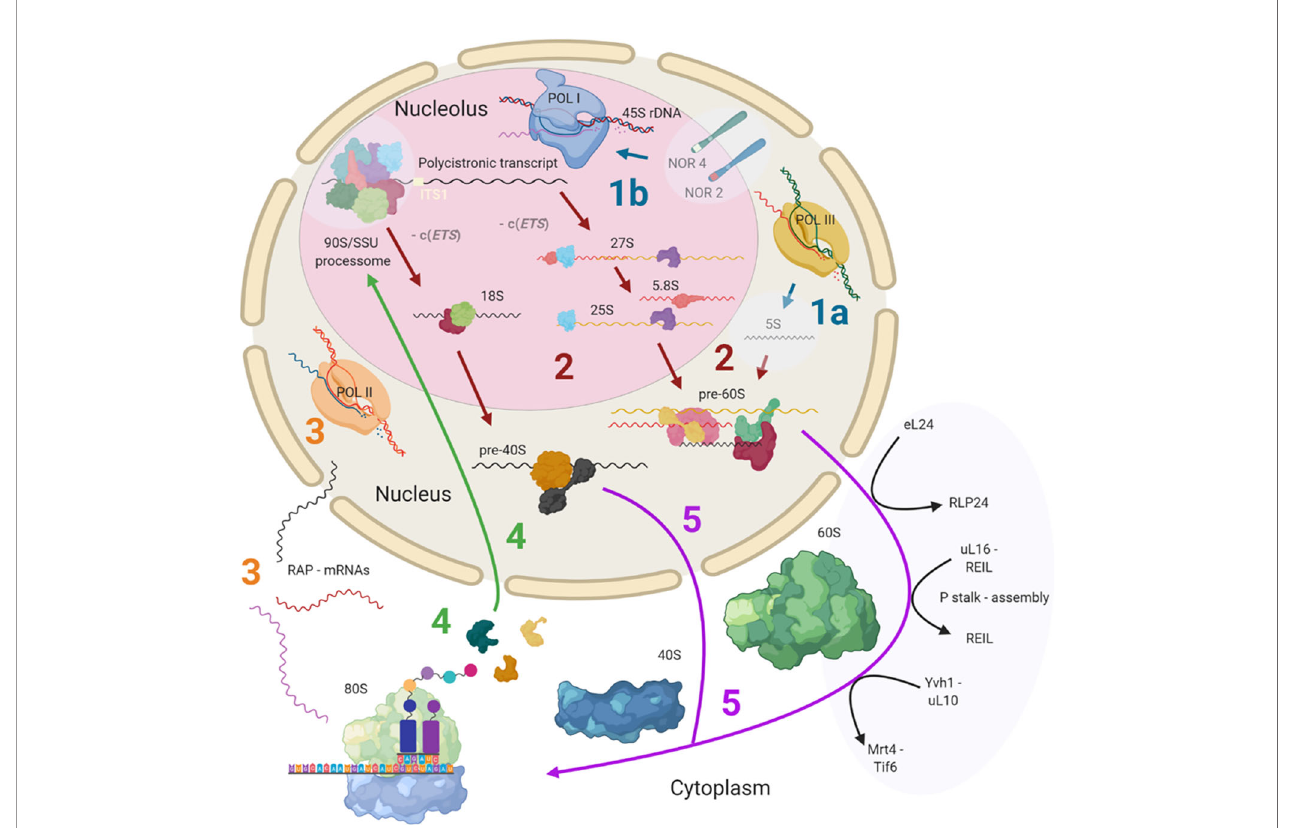
FIGURE 1 | Simpli fi ed scheme of plant cytosolic ribosome biogenesis highlighting the potential steps at which structural heterogeneity may occur and can be controlled. Biogenesis is complex and involves at least three cell compartments, the nucleolus, the nucleoplasm, and the cytoplasm. (Step 1A) 5S rRNA is transcribed by RNA polymerase III (POL III) in the nucleus. (Step 1B) The 45S rDNA, localized in the nucleolus, is transcribed into a polycistronic transcript containing 18S, 5.8S and 25S rRNAs by RNA polymerase I (POL I). Heterogeneity may rise from rDNA loci coding for different rRNA species. (Step 2) The large pre-rRNA transcript forms the 90S pre-ribosome/SSU processome, a large ribonucleoprotein complex, which is processed into pre-40S and pre-60S subunits after the splicing event on ITS1. Biogenesis factors are temporarily recruited and ribosomal proteins (RPs) are permanently assembled while rRNA is successively processed. Heterogeneity may result from the recruitment of different rRNAs and ribosome-associated proteins (RAPs), including RPs and RP paralogs. (Step 3) The RAPs are transcribed by RNA polymerase II (POL II). Heterogeneity can result from the changed availability of transcripts for subsequent translation or the presence of different splicing variants. (Step 4) RPs and other RAPs are translated in the cytoplasm and imported into the nucleus where they are assembled or assist the assembly process. Heterogeneity may be caused by availability of divergent RAP and RP paralogs at the time and location of assembly within the nucleus. (Step 5) The nuclear ribosomal pre-subunits are exported to the cytoplasm where they undergo the fi nal maturation steps that render the subunits translationally competent (black arrows). Heterogeneity may arise from the last steps of ribosome biogenesis mediated by RAPs. Posttranscriptional or posttranslational modi fi cations of all components may occur at any stage during or post ribosome biogenesis. Note that some processes and or structure-derived insights have yet to be described in plants (light blue transparencies highlights), and these gaps have been fi lled with knowledge from other model eukaryotes. The fi gure was created with BioRender (www.biorender.com) and exported under a paid subscription. 5 ’ or 3 ’ external transcribed spacer c(ETS), internal transcribed spacer (ITS), nucleolar organizer regions